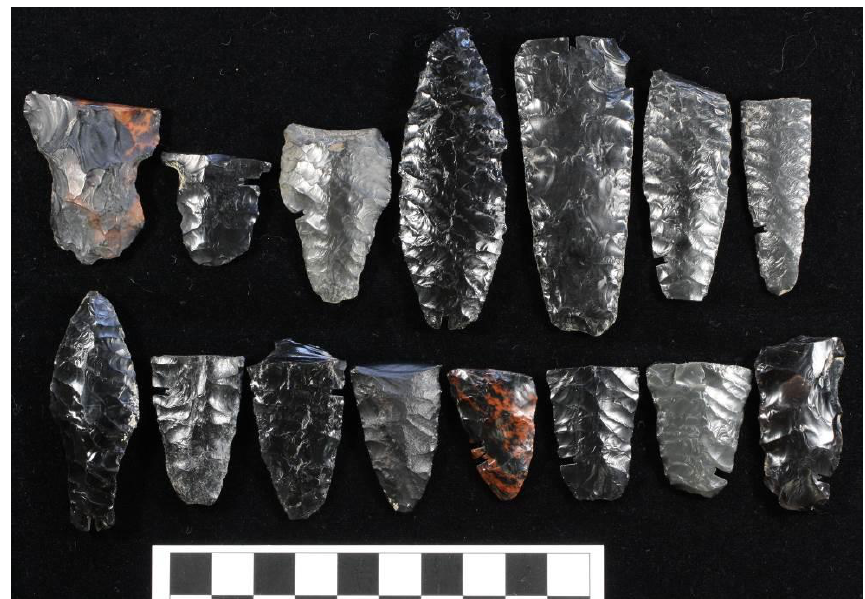
Figure 2. A sampling of the diagnostic projectile points recovered through surface collections and excavation at Rimrock Draw Rockshelter. (Photo by Katrina